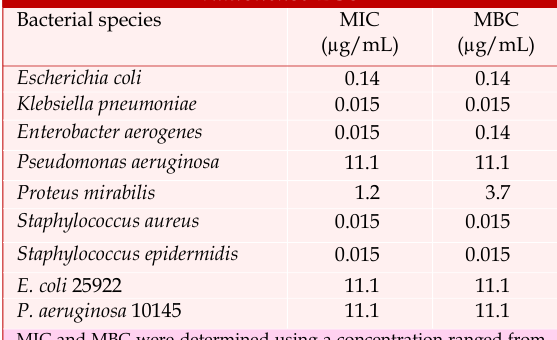
Minimum inhibitory concentrations (MICs) and Minimum bactericidal concentrations (MBCs) of